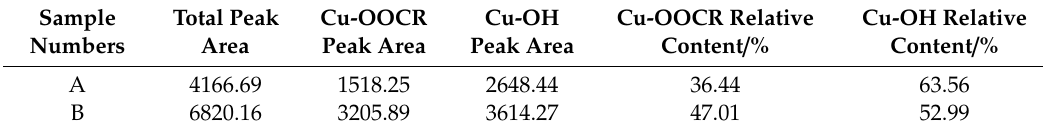
Table 5. Valence bond and proportion of Cu on mineral